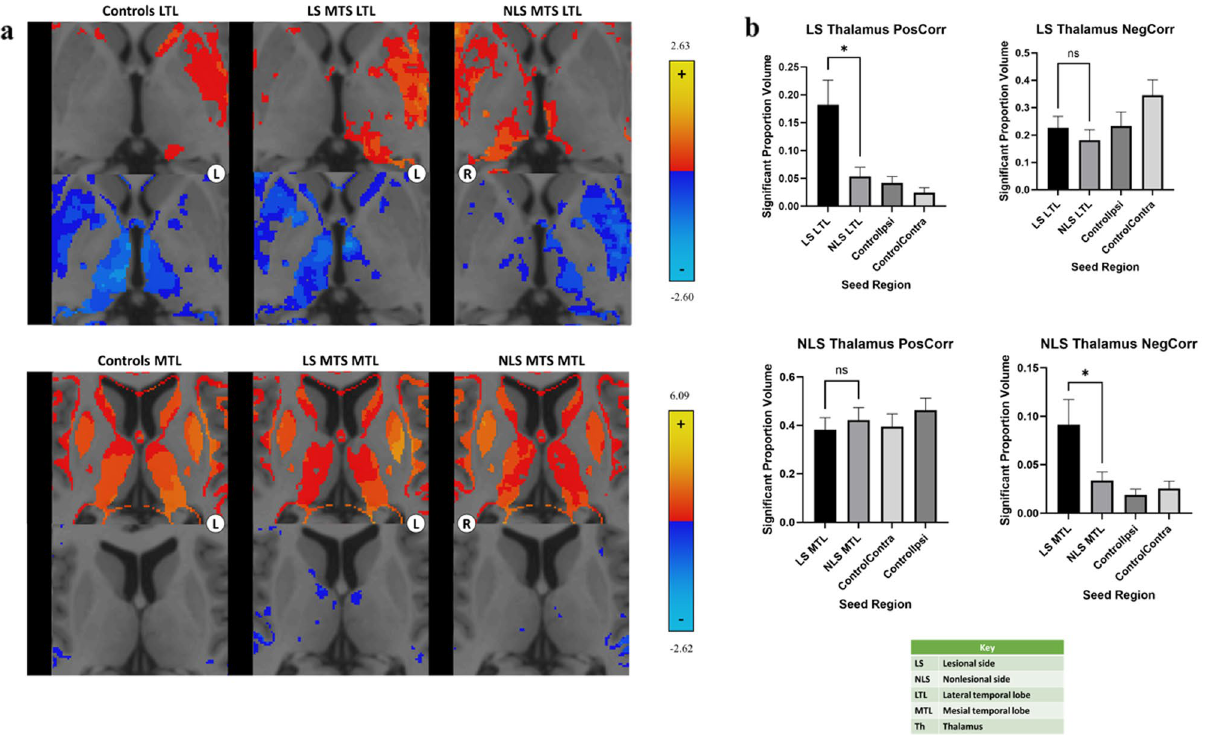
Figure 3. LTL and MTL connectivity to the thalamus. ( a ) Heatmaps of correlations from the LTL (top) and MTL (bottom) to the thalamus are shown. Heatmaps of patients with mTLE with MTS with a right-sided focus were mirrored so that the focus of all patients was on the anatomical left side for visualization. These were combined with heatmaps from patients with a left-sided MTS focus. Regions with z > 2.5 or z < − 2.5 are shown. Images are displayed in radiographic orientation. The anatomic left and right sides of the images are marked with L and R; the side that was chosen as the seed is the one marked on the image. ( b ) Comparisons between connectivity from the LS and NLS LTL (top) and MTL (bottom) to the thalamus are shown based on laterality of connections. ControlIpsi shows connectivity from the temporal lobe seed to the ipsilateral thalamus; ControlContra shows connectivity from the temporal lobe seed to the contralateral thalamus. Correlations with significant differences are marked in the graphs with *. Selected nonsignificant differences are marked with “ns” for